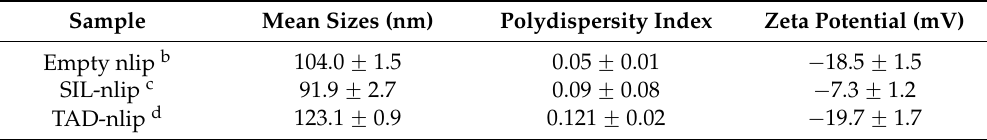
Figure 1. Transmission electron microscopy (TEM) micrographs of empty nanoliposomes ( A ); SIL-nanoliposomes ( B ) and TAD-nanoliposomes ( C ). Bar: 200 nm. Table 2. Physicochemical properties of sildenafil citrate and tadalafil used for encapsulation Table 1. Physico-chemical parameters of nanoliposomes. a within nanoliposomes.